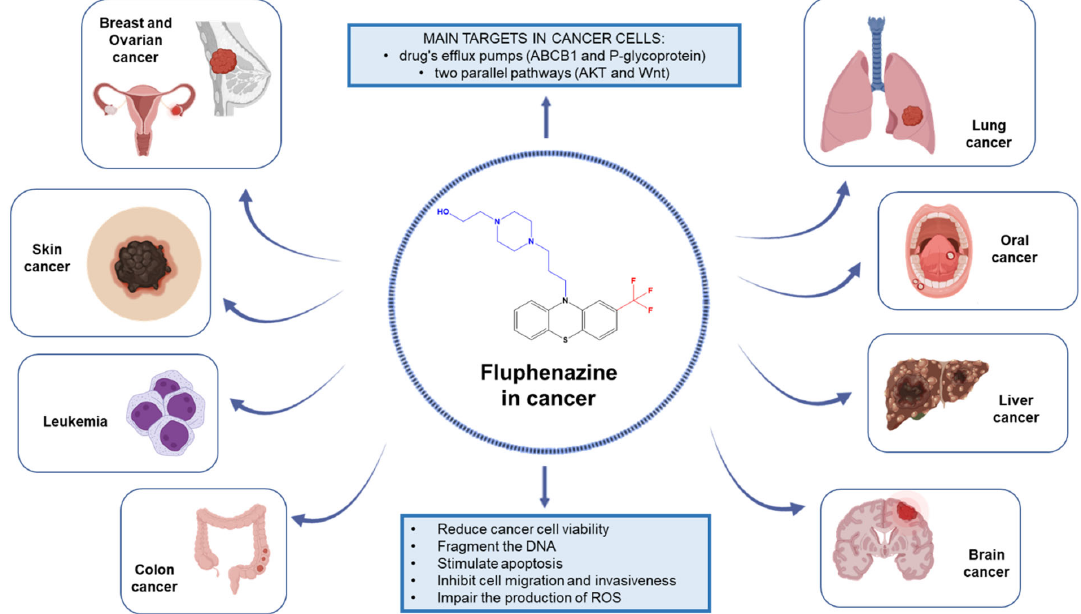
Figure 2. Overview of this review and main findings on the research of fluphenazine in